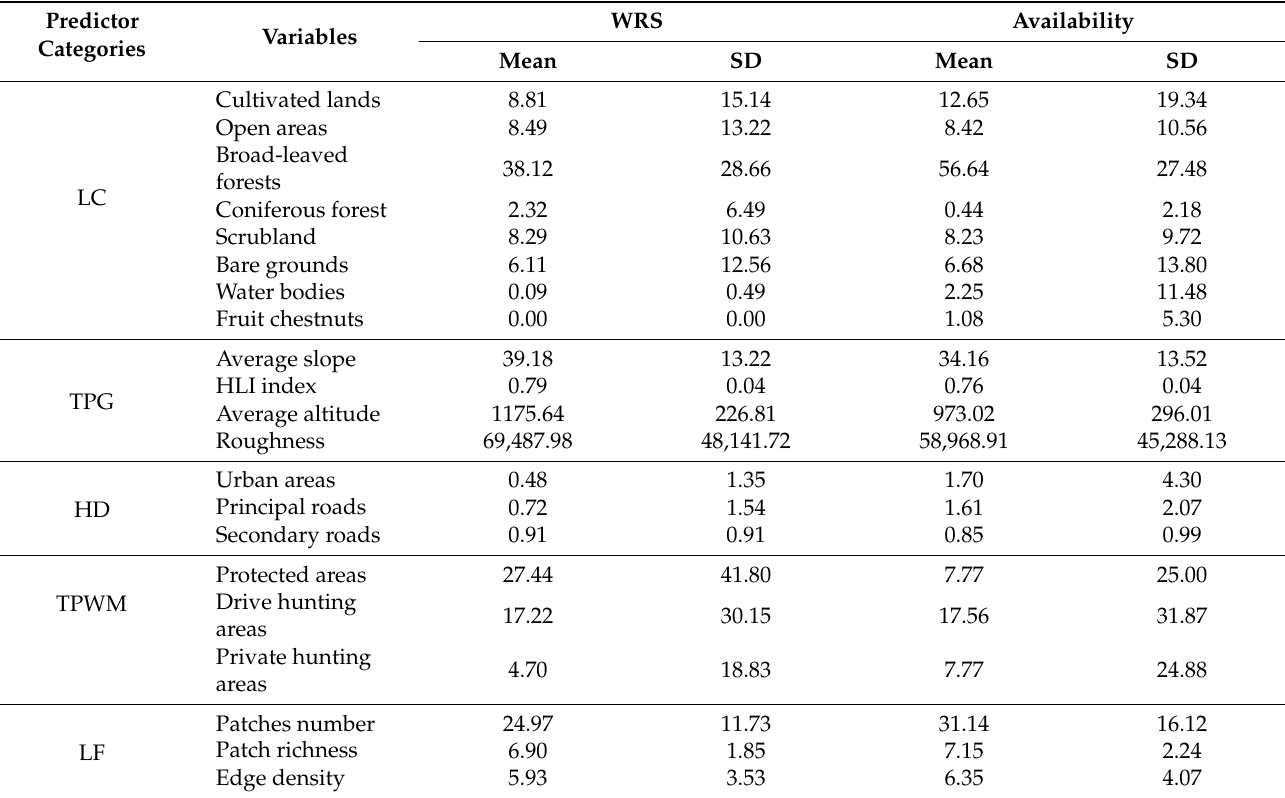
Table 3. Characteristics (mean ± SD) of the investigated variables for WRS ( n = 58) and availability ( n = 323). Predictor